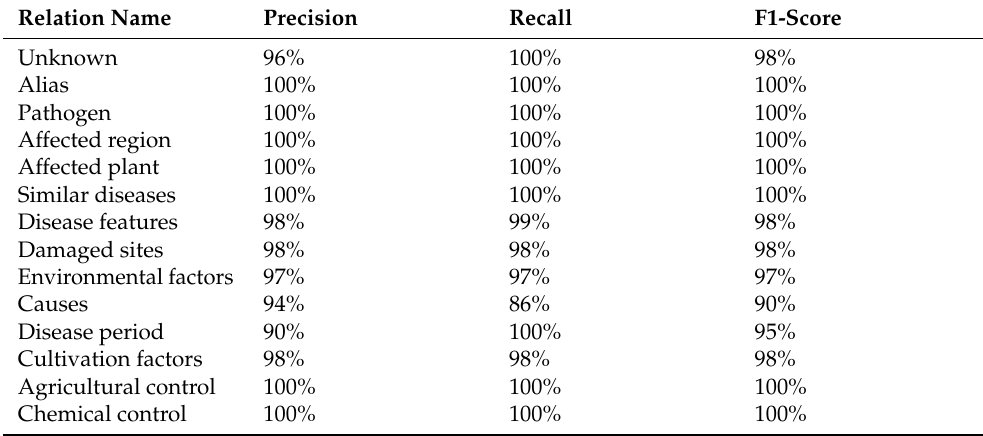
Table 7. Relation recognition results.